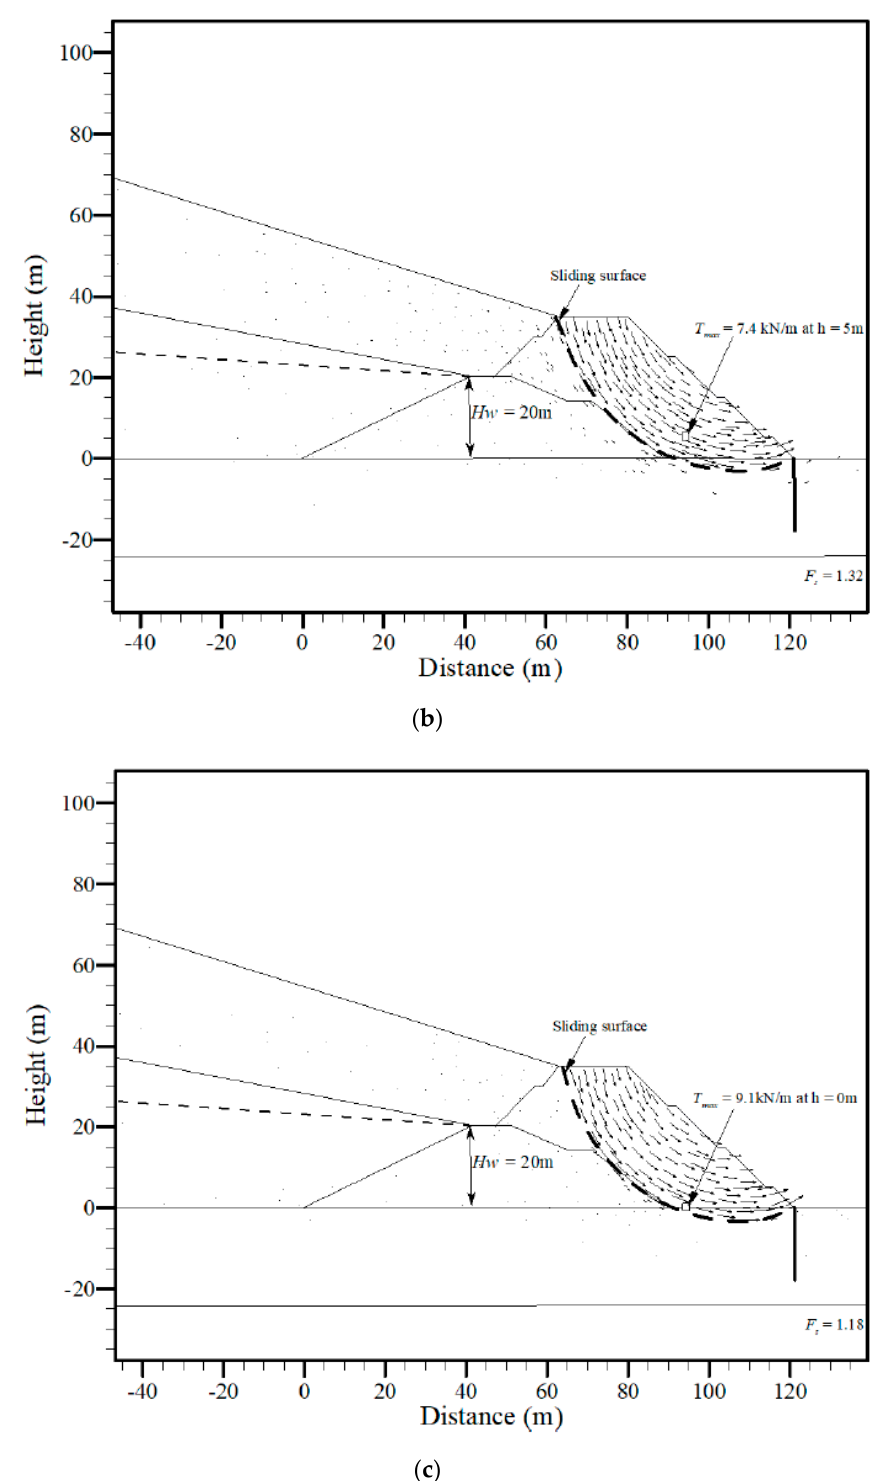
Figure 8. Effect of geotextile strength: ( a ) Baseline ( T 5%,l = 20 kN/m), ( b ) Geotextile I ( T 5%,l = 15 kN/m), Figure 8. E ff ect of geotextile strength: ( a ) Baseline ( T 5%,l = 20 kN / m), ( b ) Geotextile I ( T 5%,l = 15 kN / m), and ( c ) Geotextile II ( T 5%,l = 10 kN/m). and ( c ) Geotextile II ( T 5%,l = 10 kN /